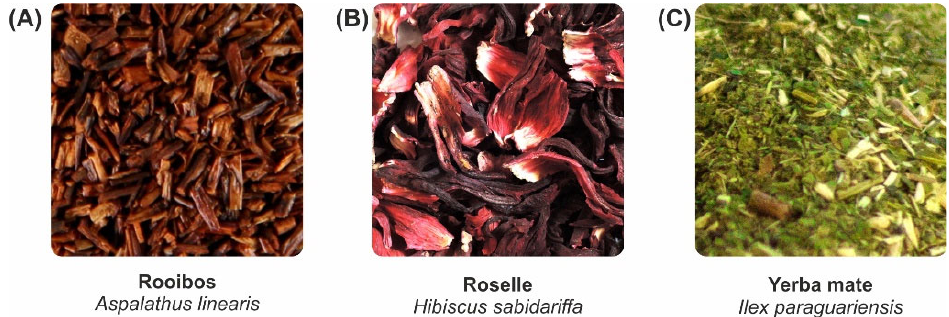
Figure 3. Commercial ( A ) rooibos, ( B ) hibiscus, and ( C ) green yerba mate dry herbal